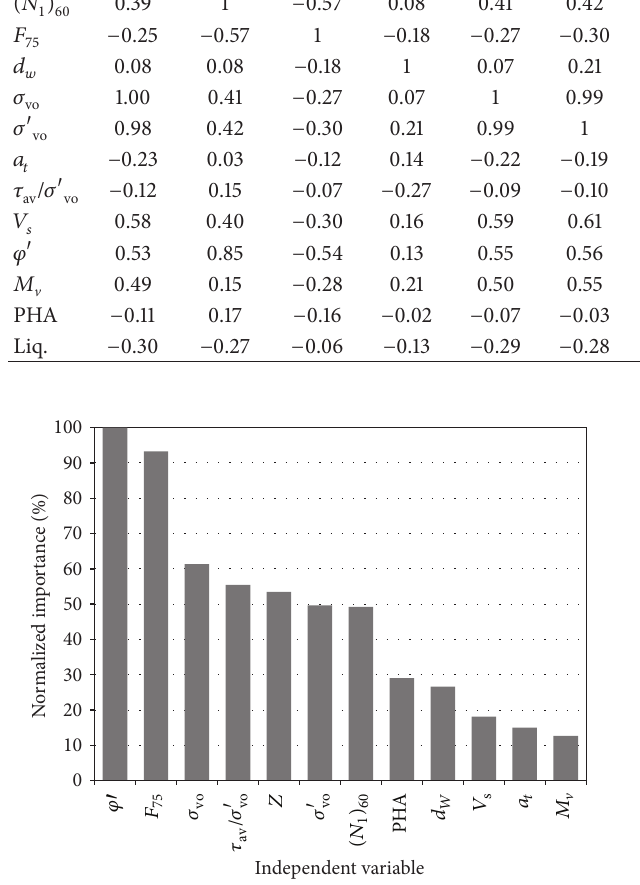
Figure 1: Importance of independent variables.